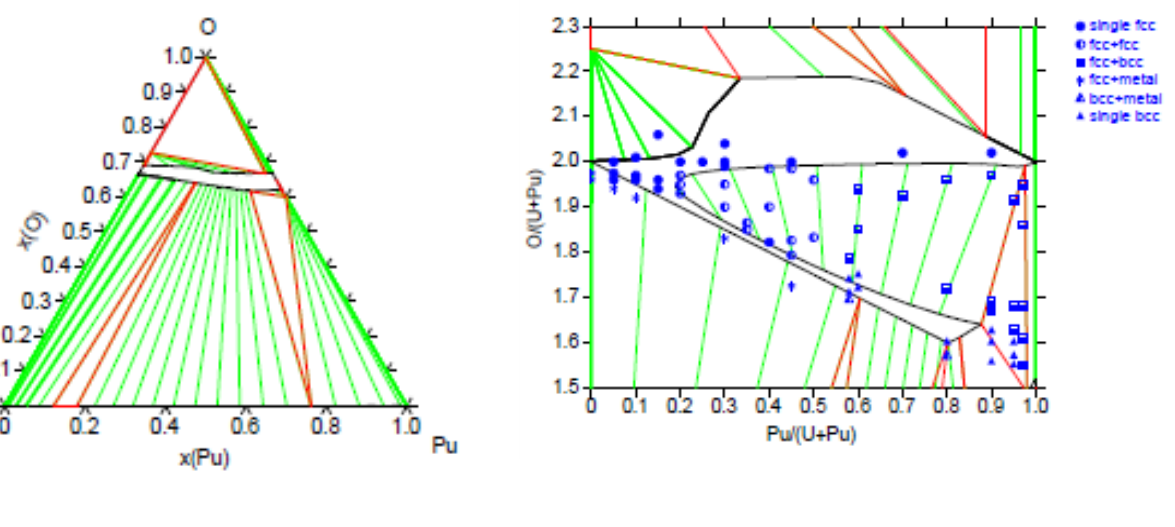
phase together the miscibility gap in the MO 2 with experimental